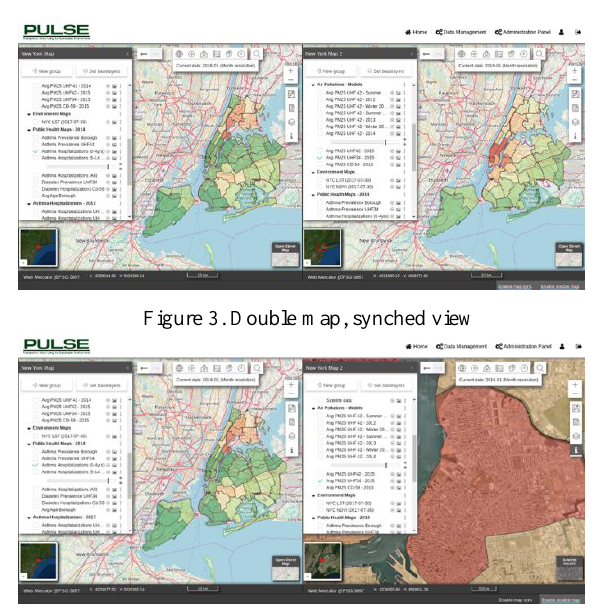
Figure 4. Double Map, independent view